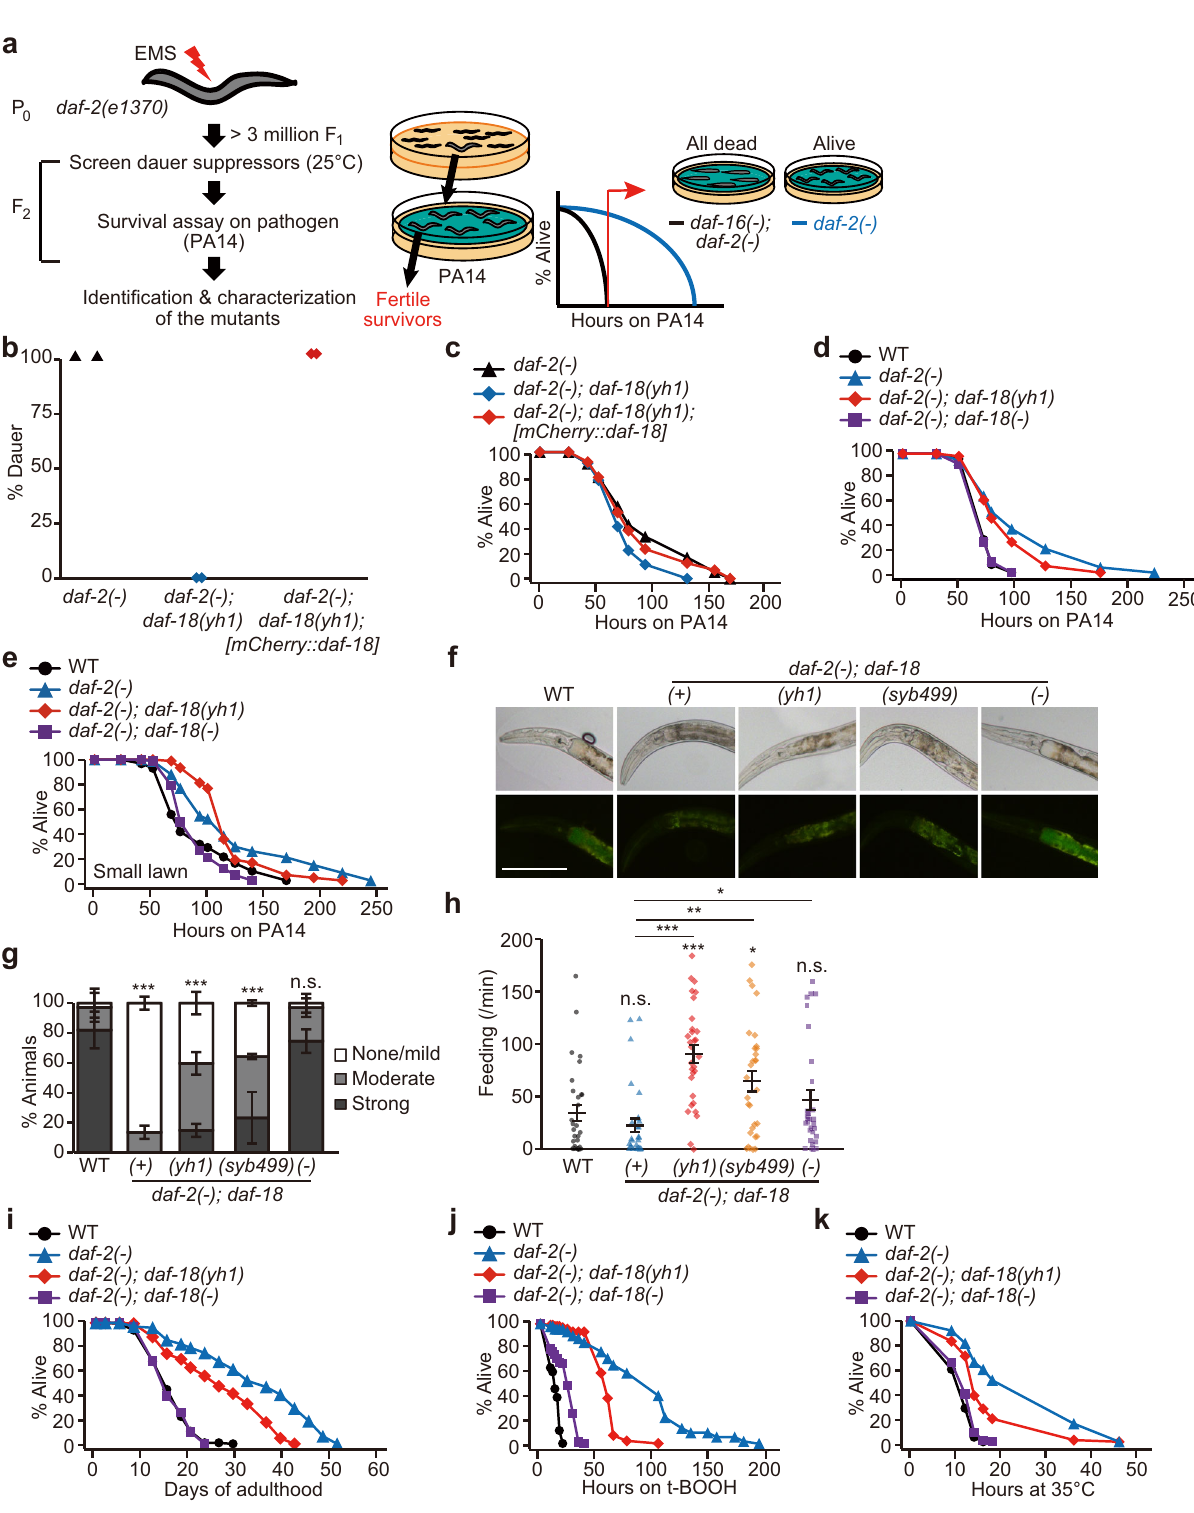
speci fi c to daf-2(e1370) . In addition, because daf-2(e1368) and age-1(hx546) mutations cause weak longevity and stress resistance phenotypes (Supplementary Fig. 3c, d, g – j) 21 – 25 , we propose that a certain level of IIS reduction is required for daf-18(yh1) to maintain longevity and immunity. mutations while maintaining overall health span . Next, we